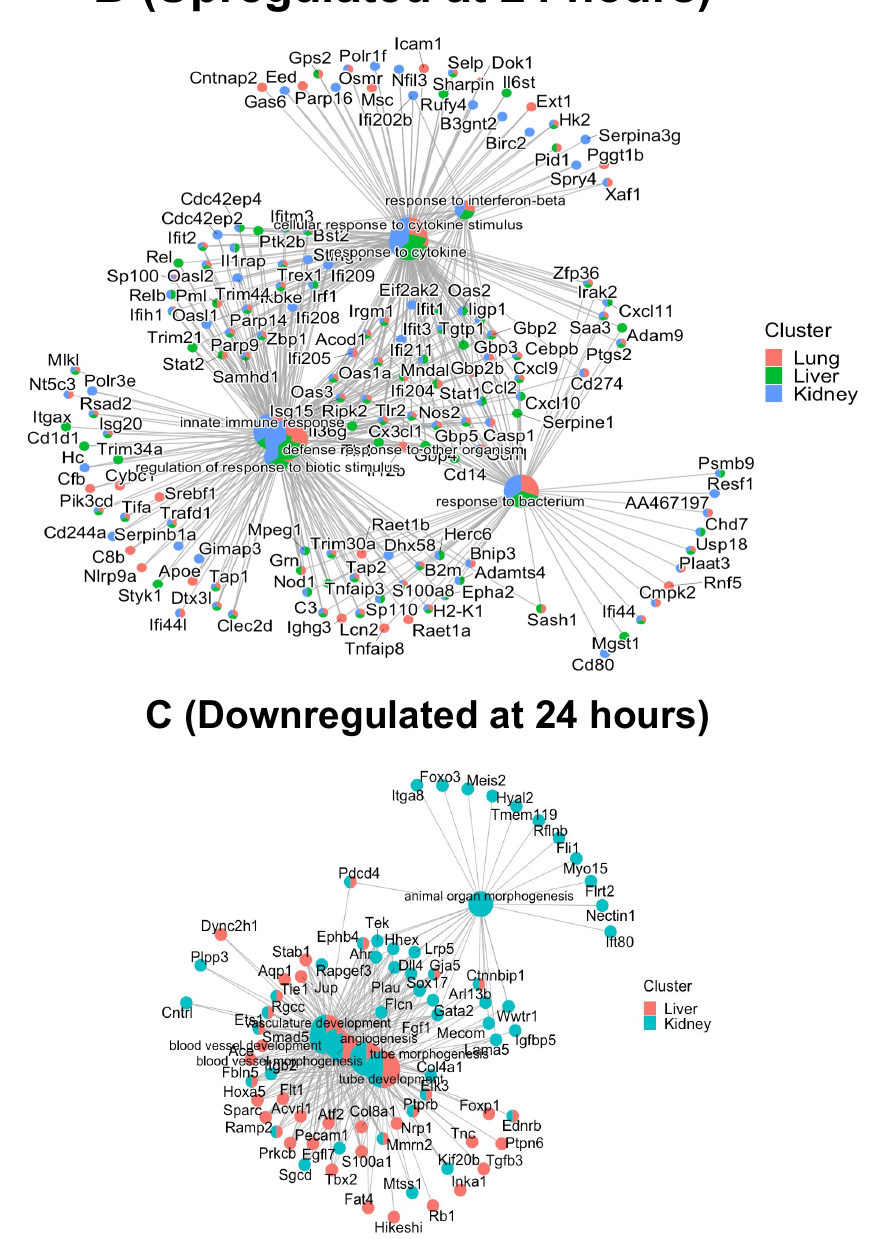
Figure 6. Cnetplots highlighting the interaction of commonly shared proteins between the top 5 GO BPs upregulated at 4 h (panel A ); 24 h (panel B ) and downregulated at 24 h (panel C ) after cytomix treatment.